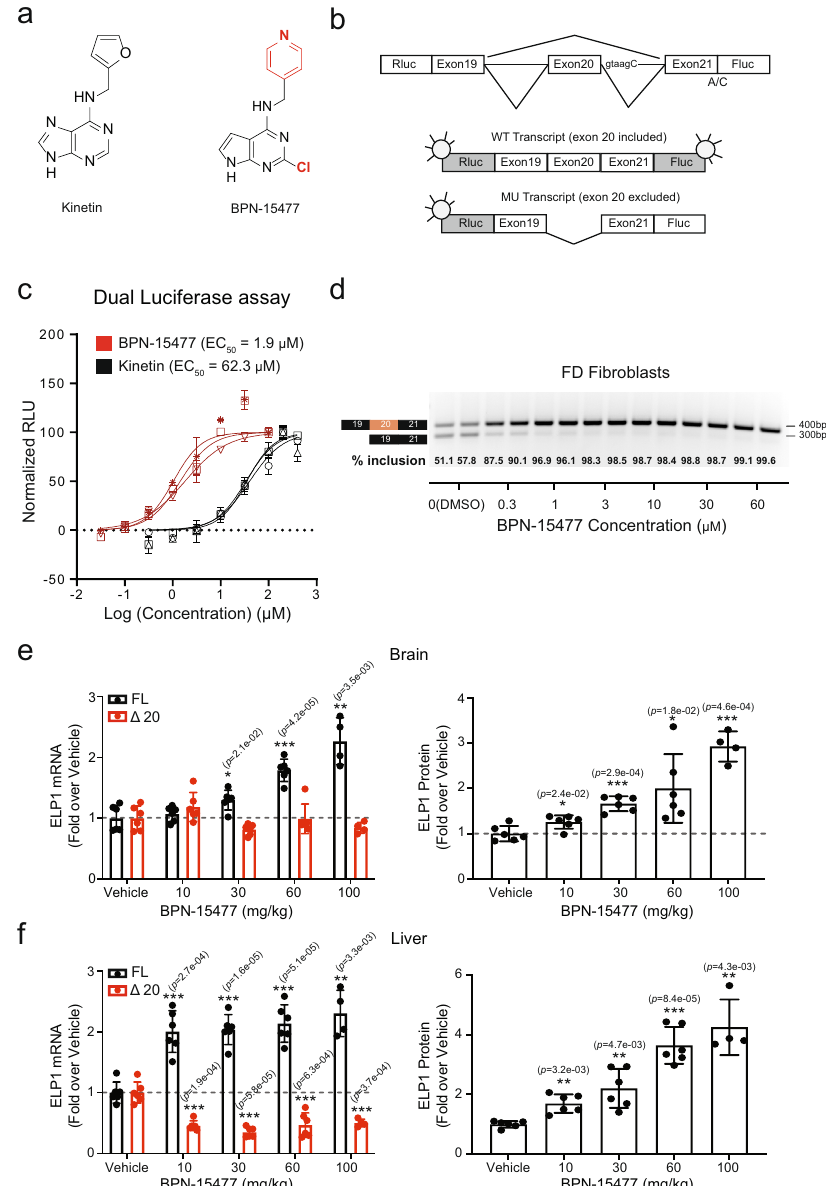
Fig. 1 Identi fi cation of the small molecule splicing modulator BPN-15477. a Molecular structure of BPN-15477 compared to kinetin, the northern heterocycle and C-2 substitution are indicated in red. b Schematic representation of the dual-reporter minigene used to measure splicing. Rluc and Fluc indicate Renilla and Fire fl y luciferase, respectively. A/C indicates the start codon mutation in Fluc and taagC indicates the location of the FD mutation. c Dose – response curves for kinetin and BPN-15477. Rluc-FD-Fluc transfected HEK293T cells treated for 24 h. Normalized relative luciferase units (RLU), which refer to the ratio between fi re fl y and renilla luciferase and provide a measure of exon 20 inclusion, are plotted as a function of compound concentration. Assays were run in triplicate and curves were created by nonlinear regression using Prism4 ( n = 3) (GraphPad Software Inc.). Data are presented as mean values ± SD. d Representative validation of BPN-15477 splicing correction in FD fi broblasts. Cells were treated for 24 h at the concentrations indicated. We independently repeated this experiment six times ( n = 6). e , f Relative expression of full-length (FL) and Δ 20 ELP1 mRNA (left panel), and ELP1 protein quanti fi cation (right panel) in brain and liver after oral doses of BPN-15477 ranging from 10 to 100 mg/kg in adult transgenic TgFD9 mouse ( n = 4 mice in the 100 mg/kg treatment group and n = 6 mice in the other groups). Comparisons are done within the same color-coded group, against the vehicle-treated mice under two-tailed Welch ’ s t -test. Data are presented as mean values ± SD. The unadjusted p values are displayed. In the fi gure, * p < 0.05; ** p < 0.01; *** p < 0.001. inclusion-response set (254 exon triplets), exclusion-response set (680 exon triplets), and the unchanged-response set (382 exon triplets with two expressed isoforms, Δ ψ < 0.01 and FDR ≥ 0.1, Supplementary Data 1). We randomly divided these sequences the validation set (20%), and the test set (10%, see “ Methods ” ). NATURE COMMUNICATIONS| (2021) 12:3332